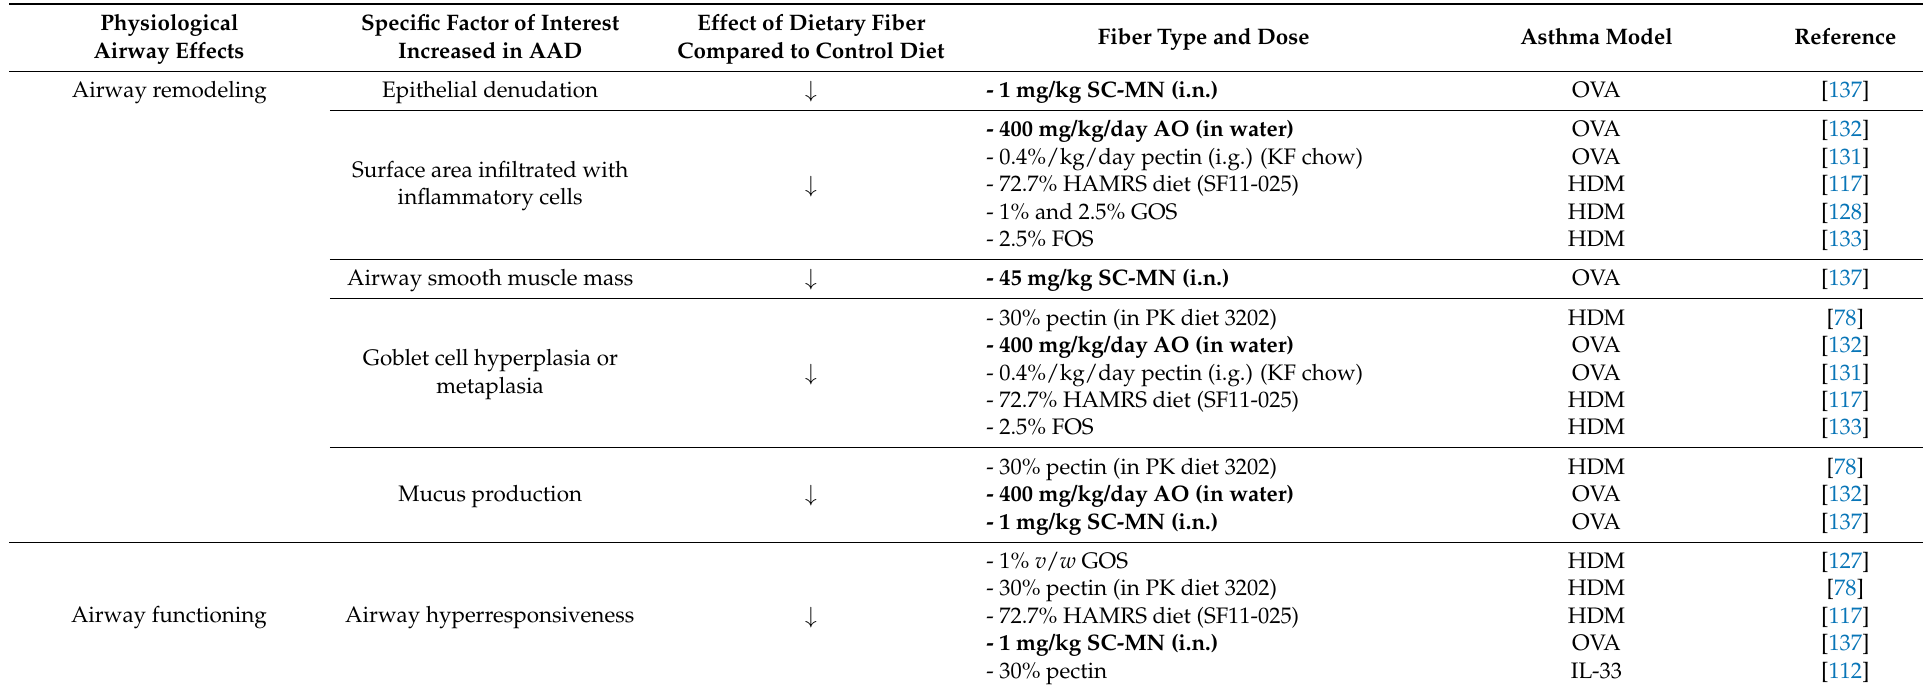
Table 2. Overview of physiological airway effects of fermentable fibers in preclinical asthma